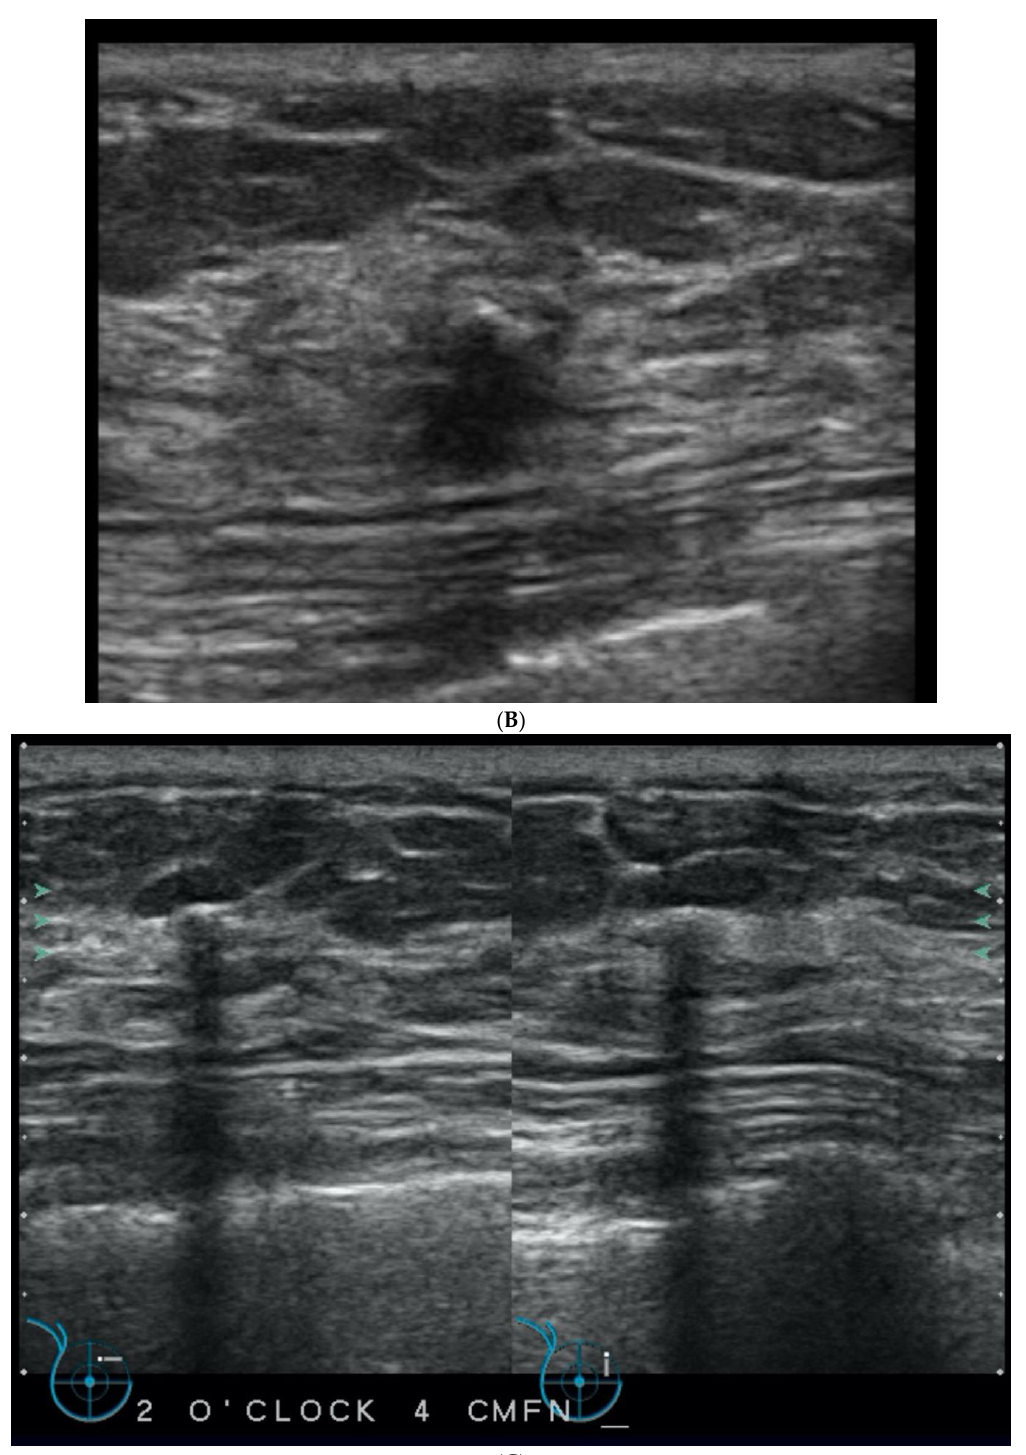
Figure 3. ( A ) Negative screening mammogram in a 73-year-old woman with category C density. Screening ultrasound showed masses in ( B ) left and ( C ) right breasts. Tomosynthesis is not part of the screening mammography program, but was performed after masses were found on US, but was also negative (not shown). Mass on left showed invasive lobular carcinoma on core biopsy. Mass on right showed atypical lobular